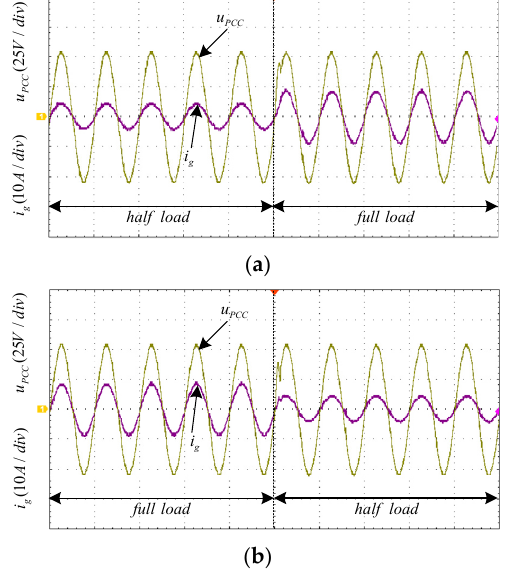
Figure 18. Experimental waveform of current and voltage at PCC when the reference current changes abruptly: ( a ) from half load to full load; ( b ) from full load to half load.